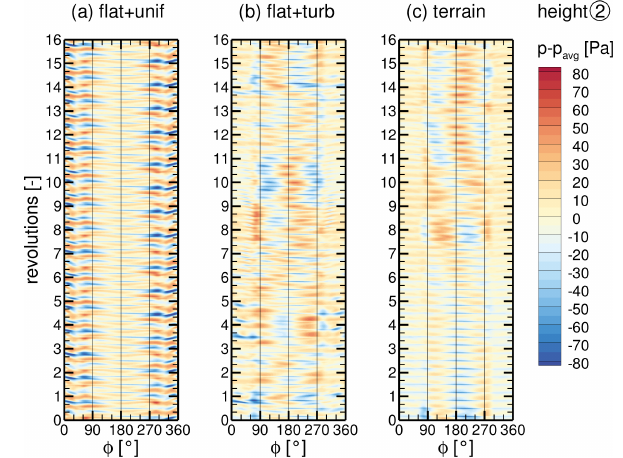
Figure 18. Power spectral density of surface pressure fluctuations on a line around the tower at height (2) for all cases (a) – (c)